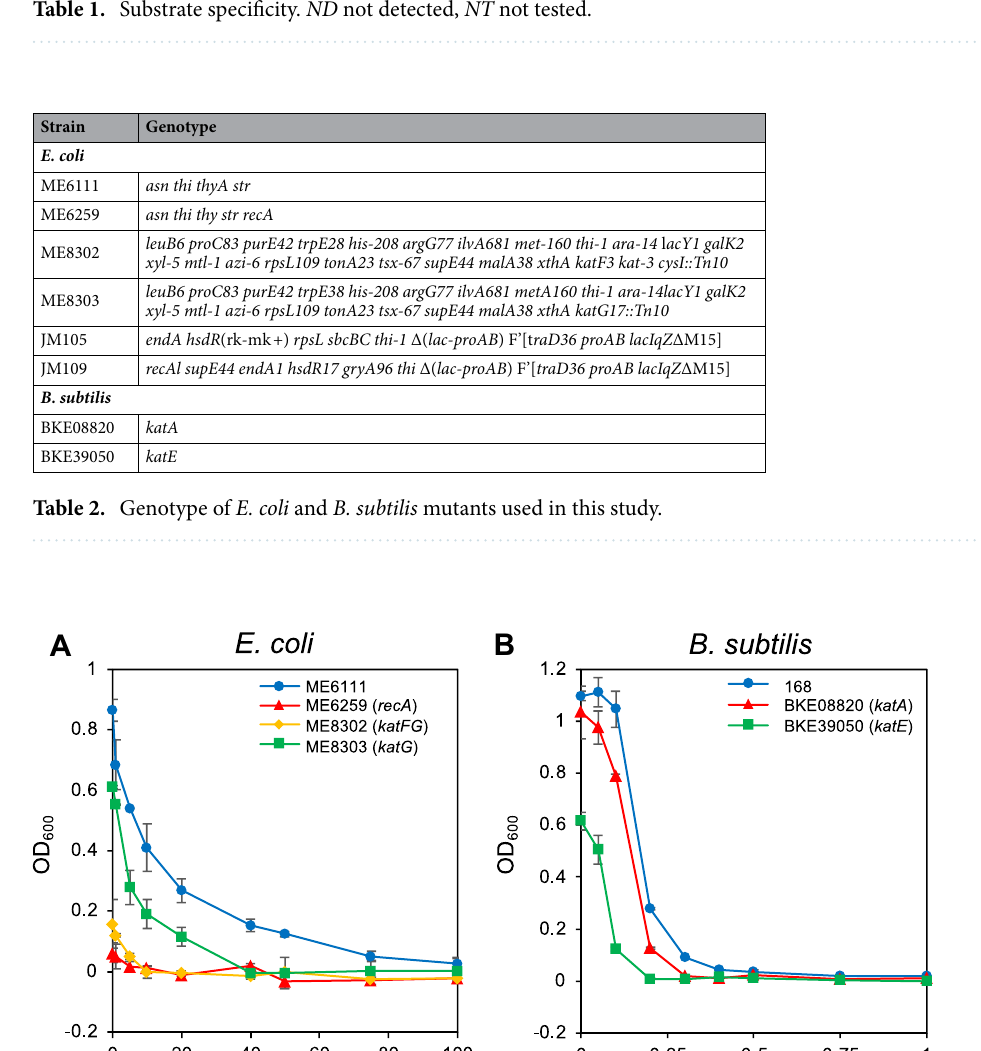
Table 1. Substrate specificity. ND not detected, NT not tested.